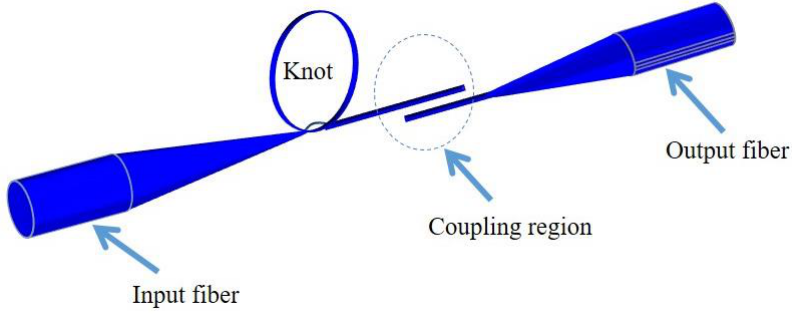
Figure 18. Schematic of the original methodology used for manufacturing KR.